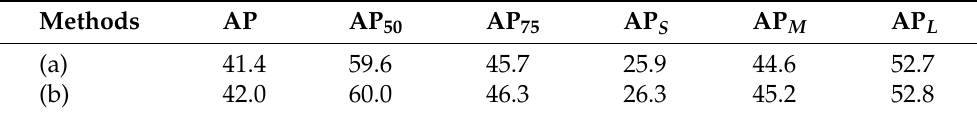
Table 7. Results of alternative architectures of objectiveness branch on COCO val2017 set. The (a) and (b) indexes in the first column denote corresponding architectures that are presented in Figure